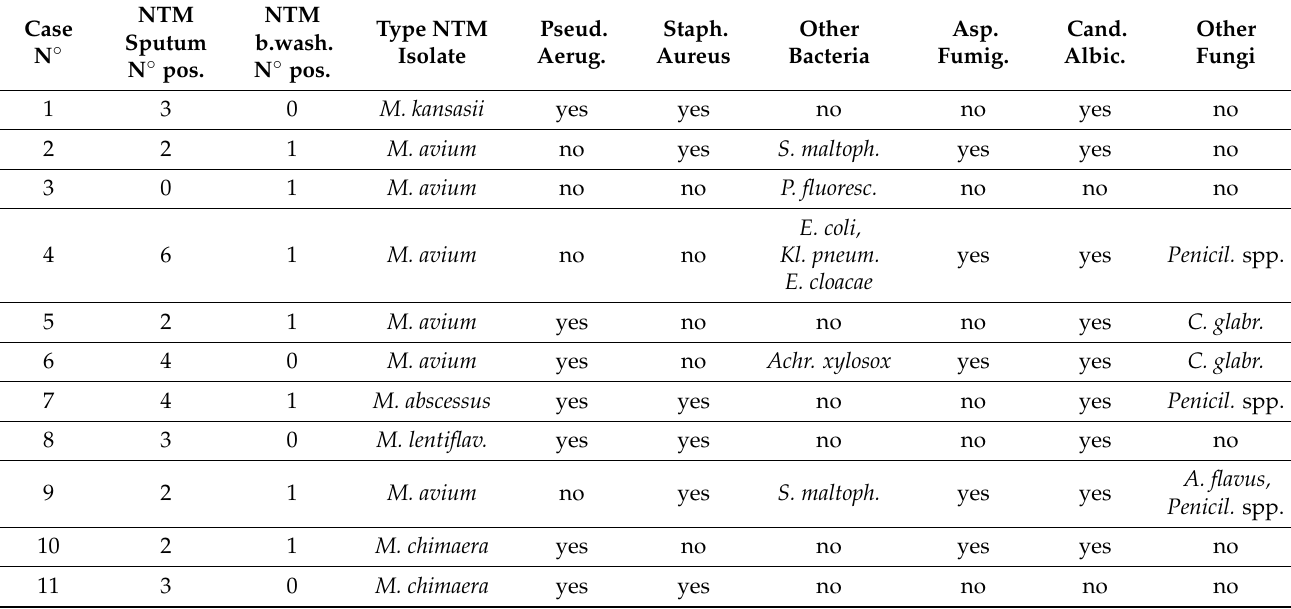
Table 1. Results of microbiological evaluation in 11 CF patients with positive NTM